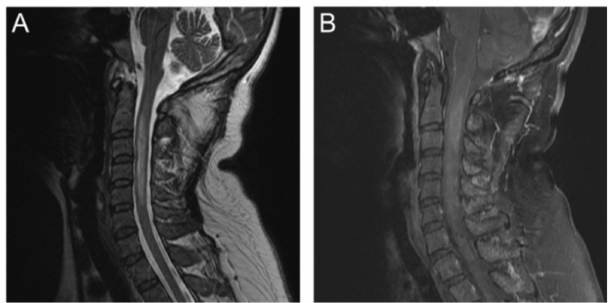
Figure 1. Initial conventional magnetic-resonance imaging MRI. ( A ) T2-weighted image (T2WI) showed mild spinal-cord swelling with hyperintensity lesion in C2–C5 spinal cord; ( B ) postcontrast T1-weighted image (T1WI) with fat suppression showed intramedullary lesion with faint enhancement in C2–C3 spinal